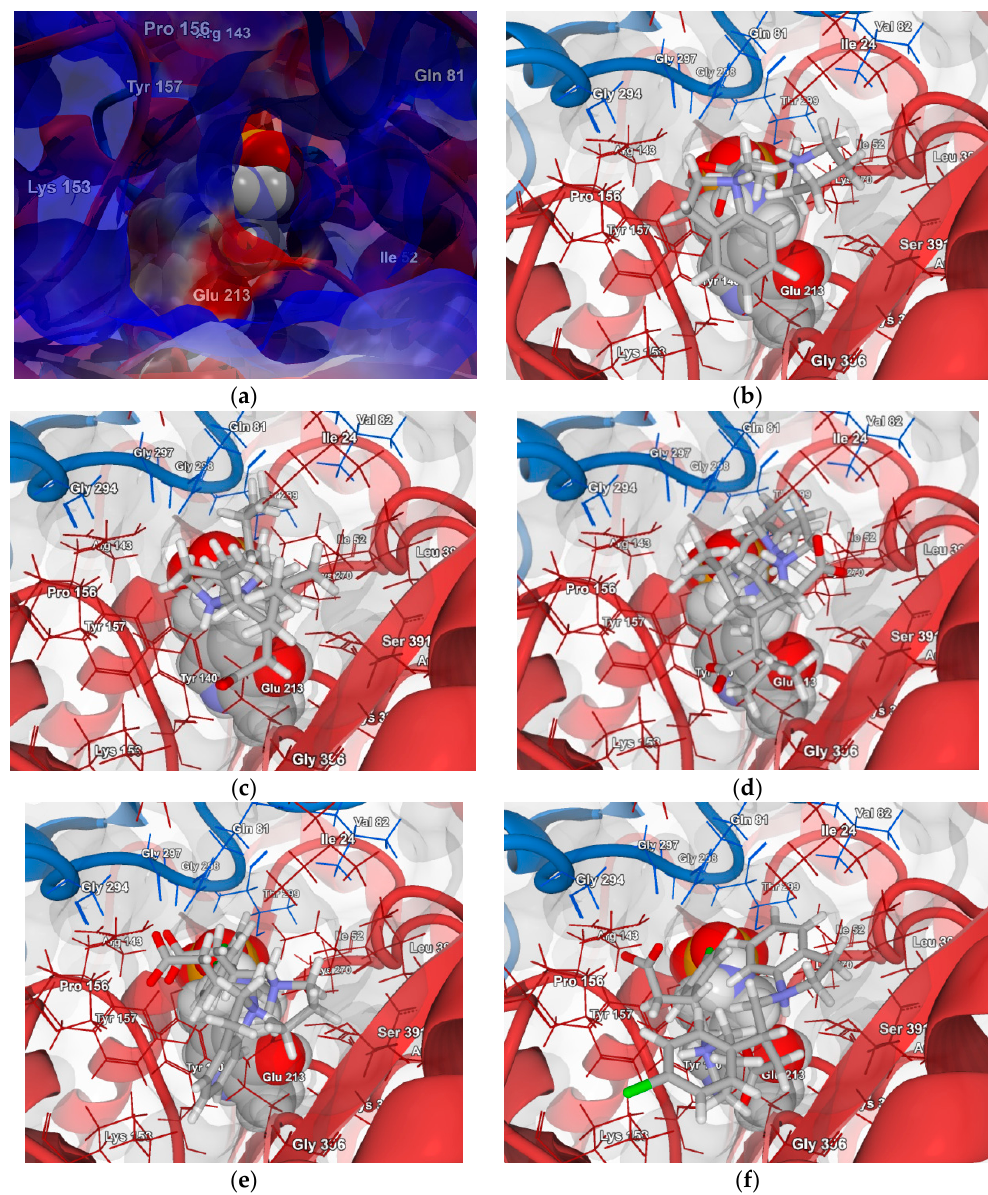
Figure 9. ( a ) Electrostatic potential map of Pseudomonas GABA-AT active site region. Blue, red and white colors represent regions with positive, negative and neutral electrostatic potential value, respectively; ( b ) GABA derivatives bound into the P seudomonas GABA-AT catalytic site; ( c ) ( S )-Pregabalin analogues bound into the Pseudomonas GABA-AT catalytic site; ( d ) ( R )-Pregabalin analogues bound into the Pseudomonas GABA-AT catalytic site; ( e ) ( S )-Baclofen analogues bound into the Pseudomonas GABA-AT catalytic site; ( f ) ( R )-Baclofen analogues bound into the pseudomonas GABA-AT catalytic site. PLP prosthetic group is shown as spacefill model.